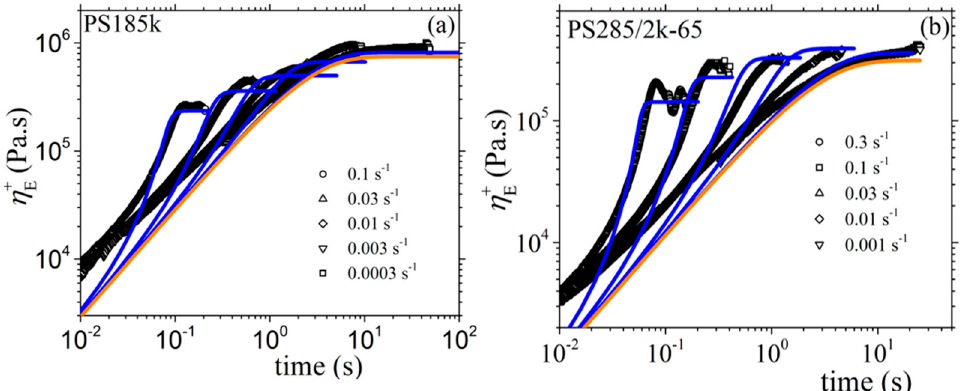
Figure 13. Comparison of the model predictions with the experimental measurements of Costanzo et al. [16] for the extensional stress growth coefficient as a function of time for several stretch rates. The thick orange line depicts the LVE envelope, Equation (17). Same parameter values as in Figure 12.